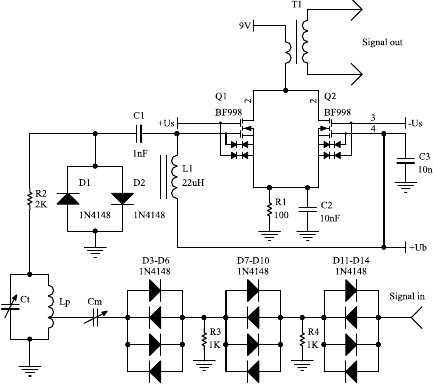
Figure 4. Circuit diagram of the input stage of the NQR spectrometer.